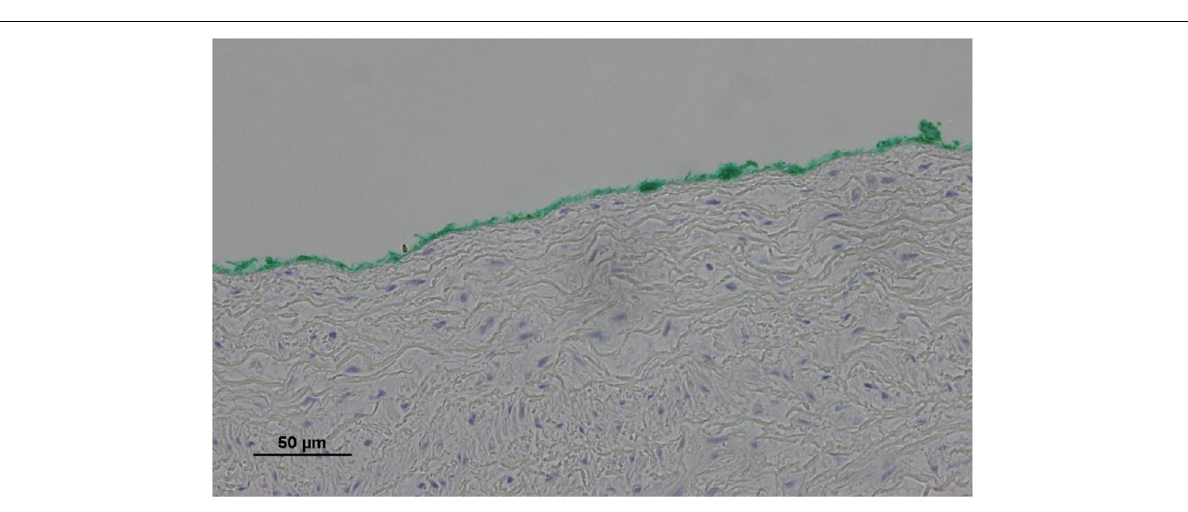
FIGURE 4 | Light microscopy view of the luminal aspect of the aorta at the AHS. Green line denotes the luminal aspect. There are no endothelial